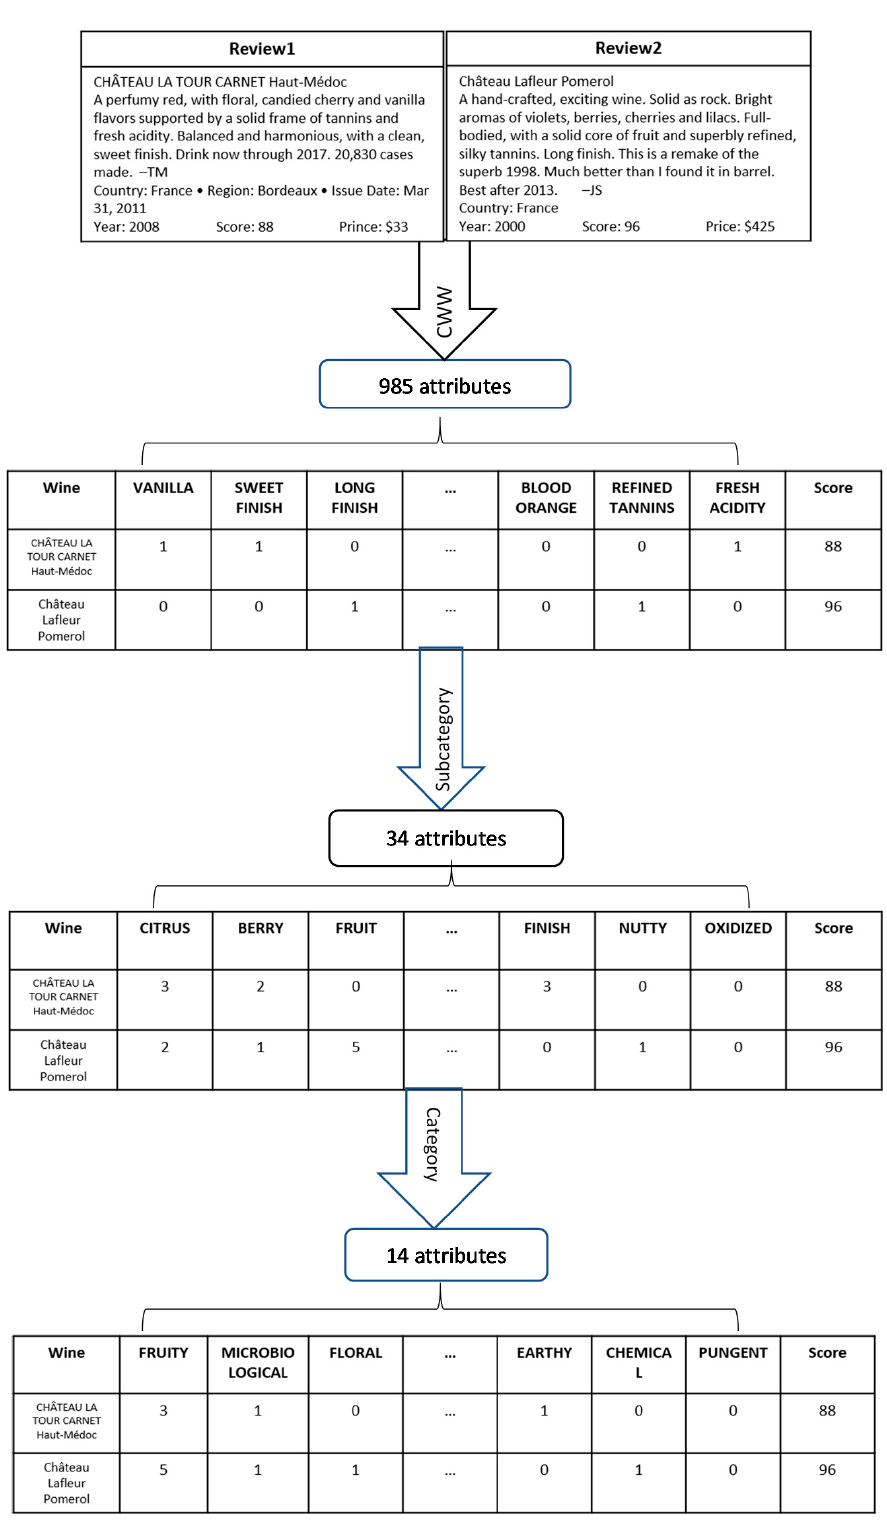
Figure 2. The process of using the computation wine wheel to convert NORMALIZED_NAME, SUBCATEGORY_NAME, and CATEGORY_NAME into a machine readable format.